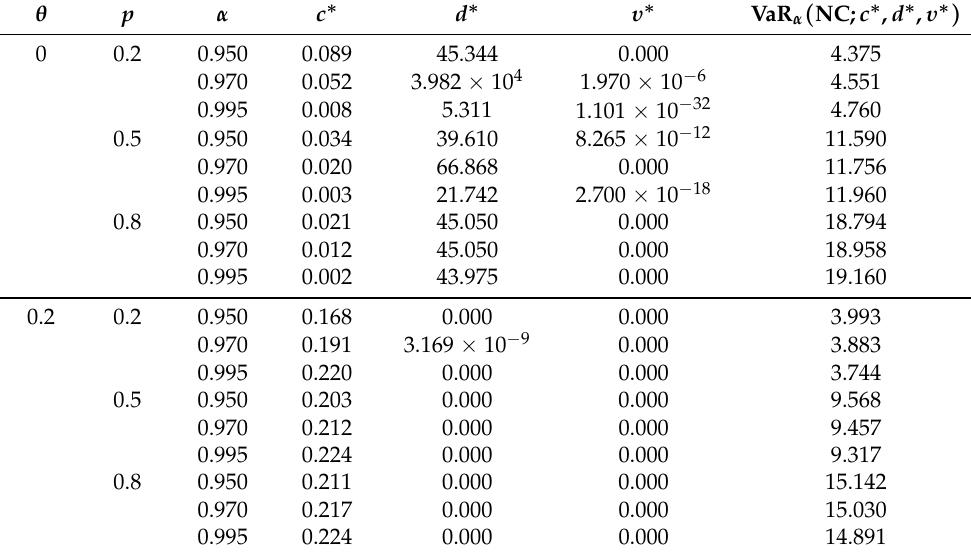
Table 4. Optimal combination of proportional and stop-loss reinsurance and the